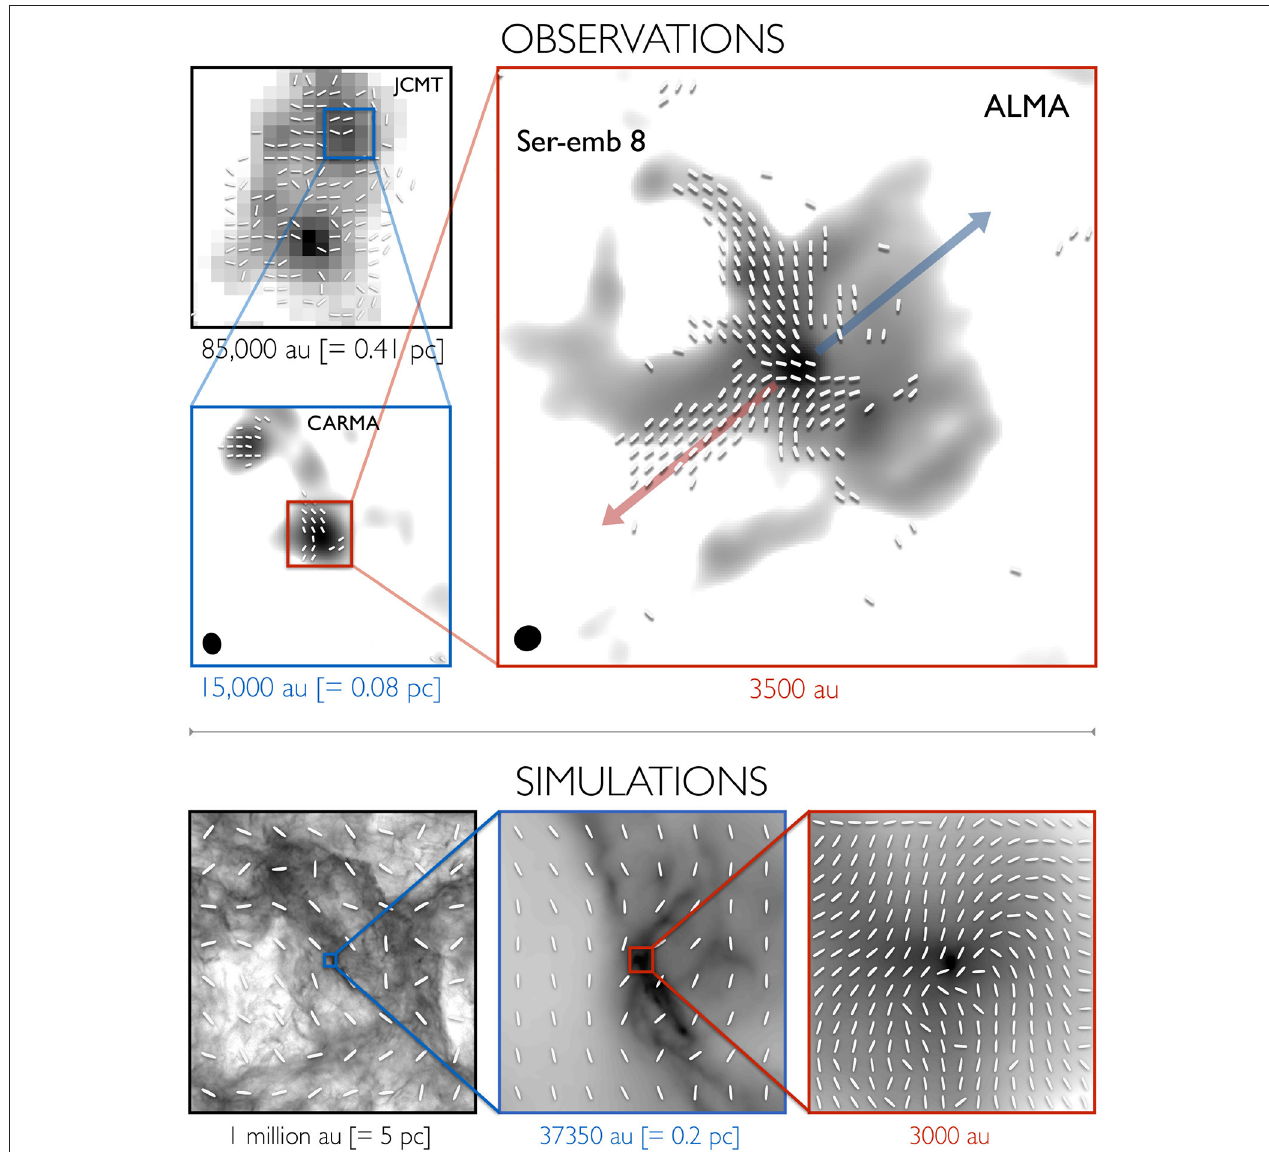
FIGURE 3 | (Top) Multi-scale observations of the magnetic field (line segments) toward the low-mass Class 0 protostar Ser-emb 8. Grayscale is total-intensity (Stokes I ) thermal dust emission. Observations are from the JCMT at 850 µ m (top-left; Matthews et al., 2009), CARMA at 1.3mm (bottom-left; Hull et al., 2014), and ALMA at 870 µ m (right). The red and blue arrows indicate the red- and blueshifted lobes of the bipolar outflow from Ser-emb 8 traced in CO( J inconsistency of the magnetic field across spatial scales, and are consistent with moving-mesh AREPO MHD simulations (Bottom) whose initial conditions include a magnetic field that is weak compared with turbulence at large (5pc) scales. Adapted from Hull et al. (2017a). Reproduced with permission from the AAS. significant deviations in the magnetic field morphology